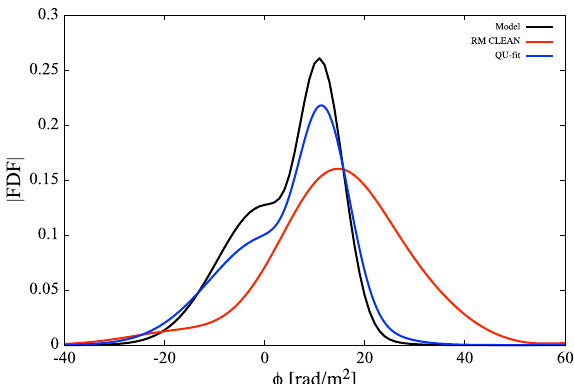
Figure 2. The reconstructed FDF by QU-fitting (blue line) of the w2g1 (g1, Gap 1) source model, cleaned FDF (red line) constructed by RM CLEAN using the same simulation data of QU-fitting, and the source model FDF (black line).